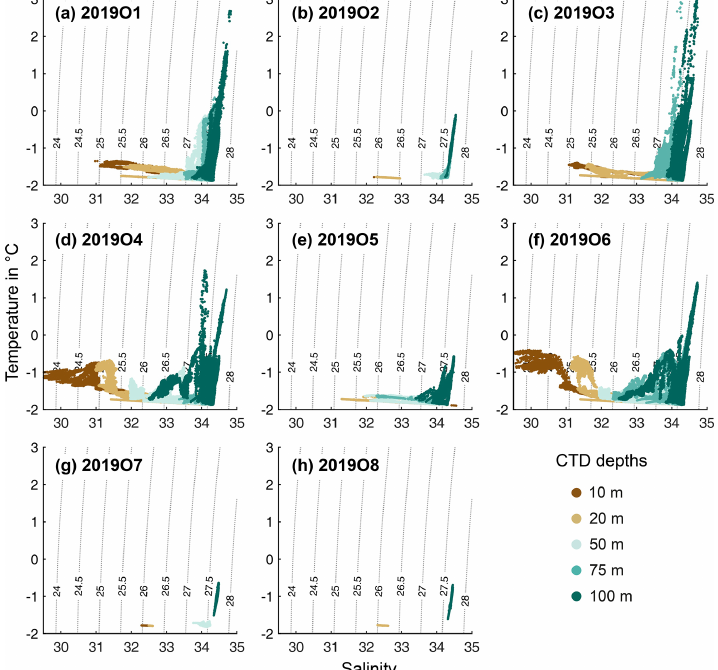
Figure A1. T − S diagrams based on the processed datasets collected by all eight buoys during their drift through the central Arctic as part of the MOSAiC DN. Note that these diagrams strongly depend on the operation lifetime of the corresponding buoy.